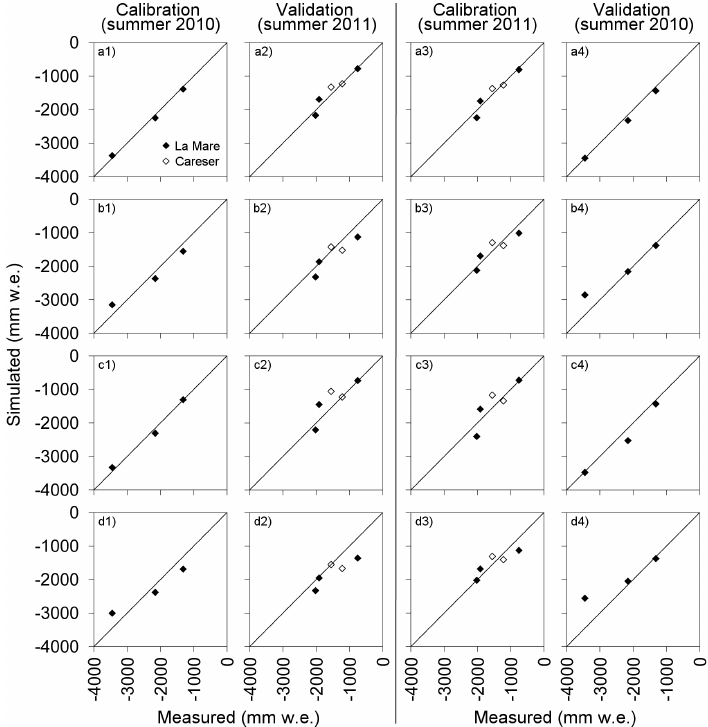
Figure 10. Measured vs. modeled mass balance at the eight glacial weather stations, using EISModel with four different air temperature inputs: (a1–a4) measured, (b1–b4) extrapolated from Car_2607 via the standard lapse rate ( − 6.5 ◦ Ckm − 1 ), (c1–c4) calculated via the G&B method, and (d1–d4) calculated via the S&M method. Corresponding statistics are reported in Table